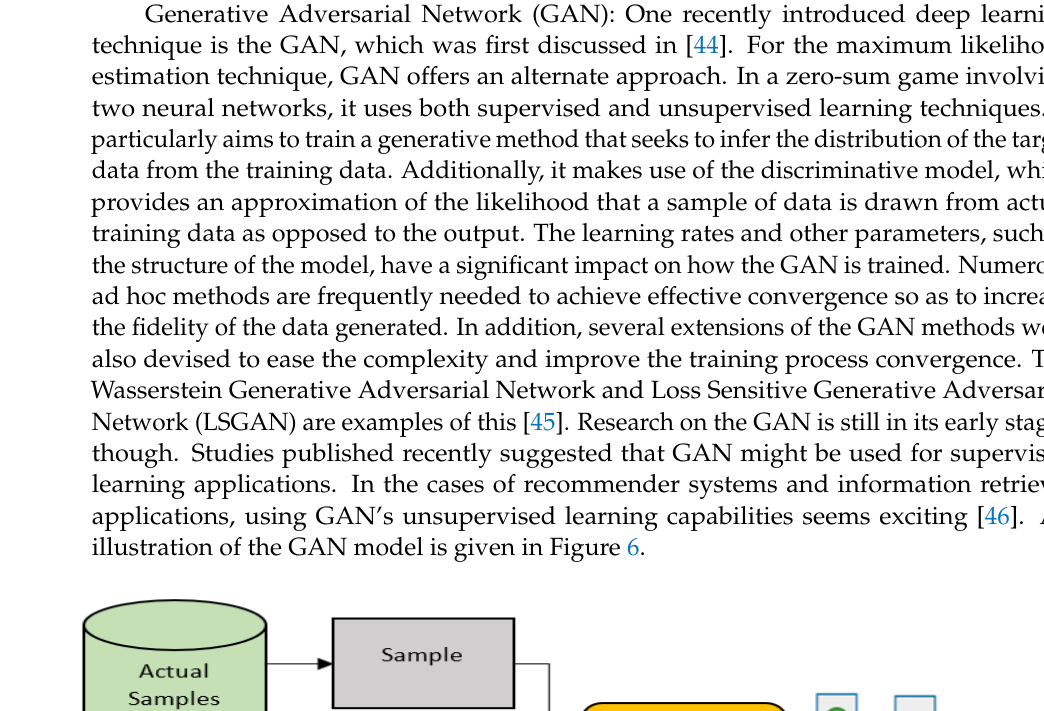
Figure 5. An illustration of the MLP.